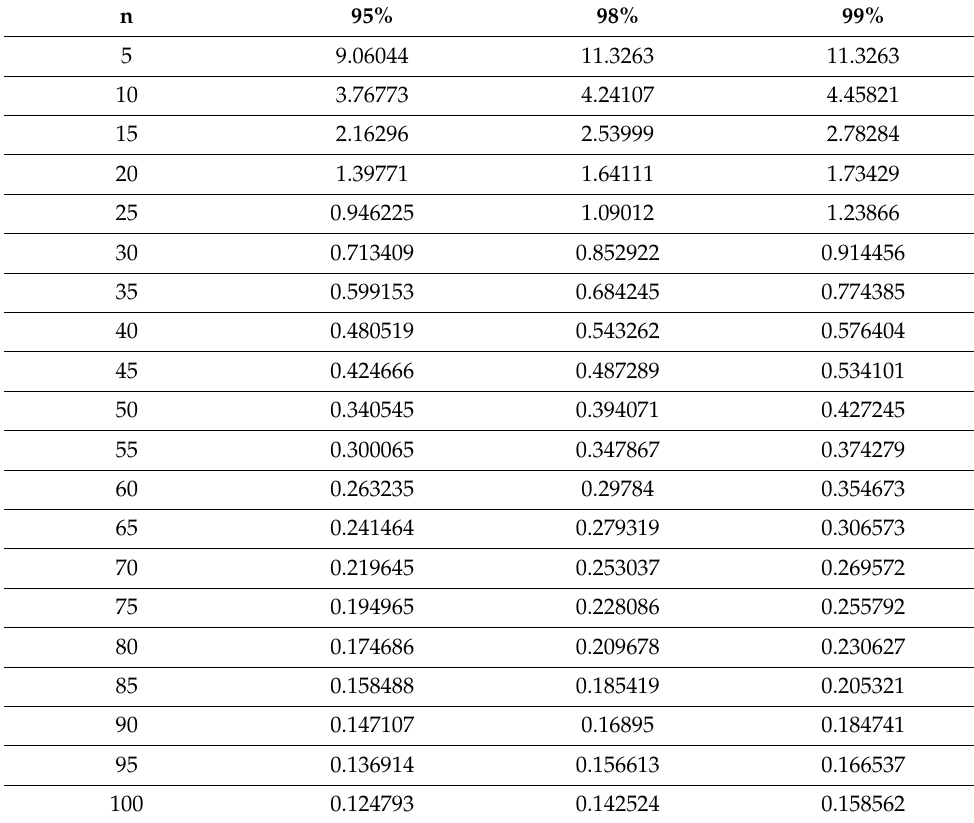
Table 5. The Higher Percentile Values of δ c ( 0.09 )